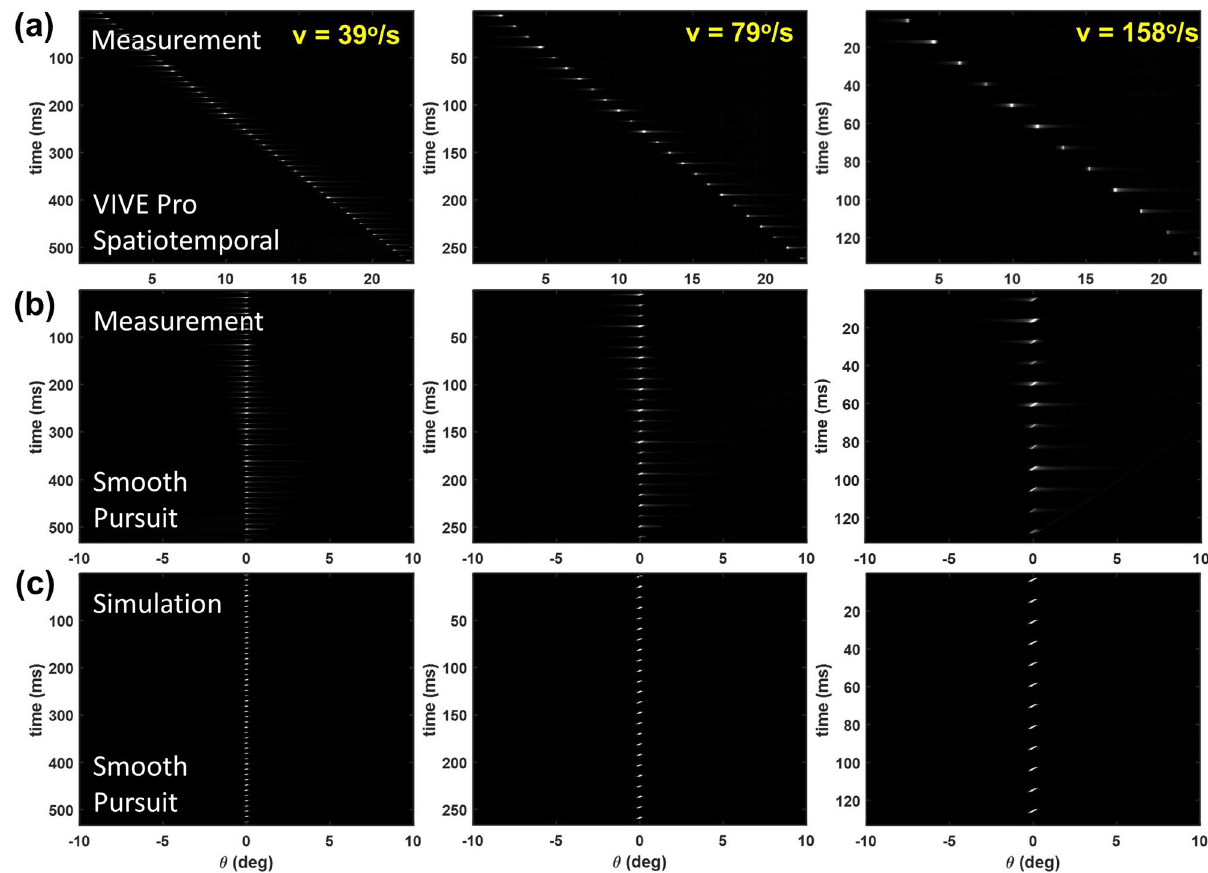
Figure 4. ( a ) Measurements of the time-dependent LSFs with respect to a static eye at target motion velocity of 39 (first column), 79 (second column), and 158°/s (third column) using the VIVE Pro. ( b ) Same measurements as in ( a ) assuming a smooth-pursuit eye movement. ( c ) Simulated time-dependent LSFs with the same target velocity as in ( a ) during smooth